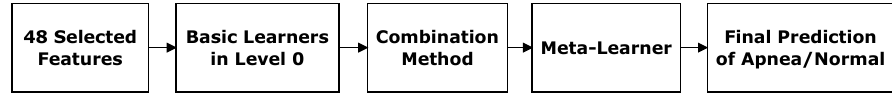
Figure 6. Basic components of the multi-error-reduction classification system.